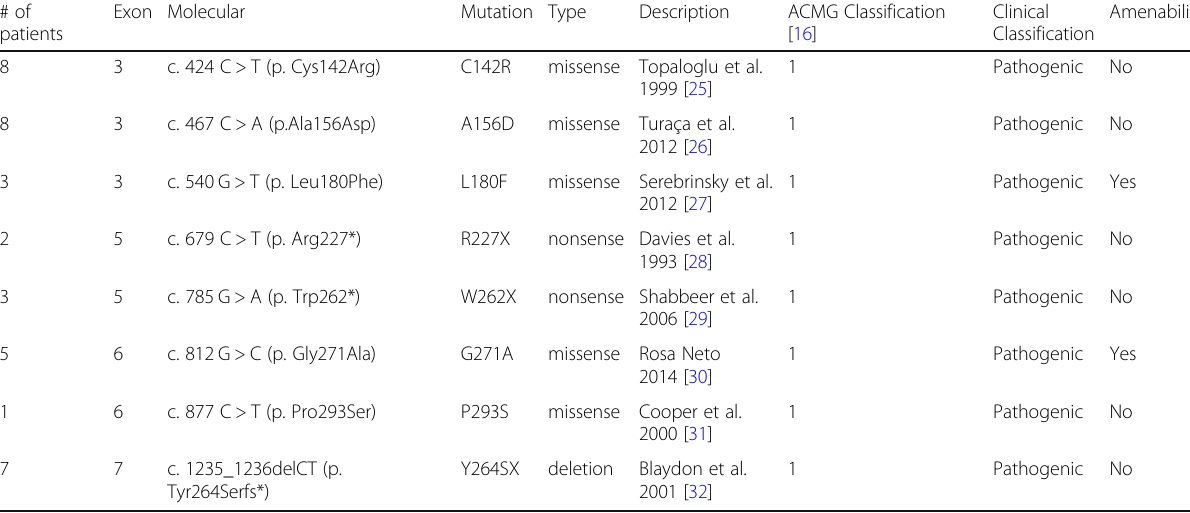
Table 1 List of mutations in this cohort of Fabry disease patients # of